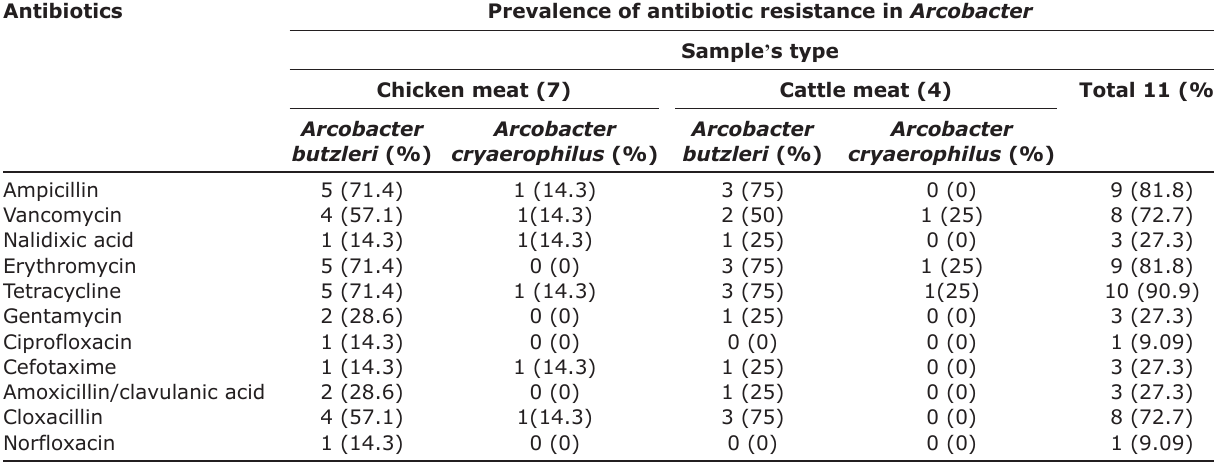
Table-3: Prevalence of antibiotic resistance in Arcobacter spp. recovered from retail meat in Wasit marketplaces. Antibiotics